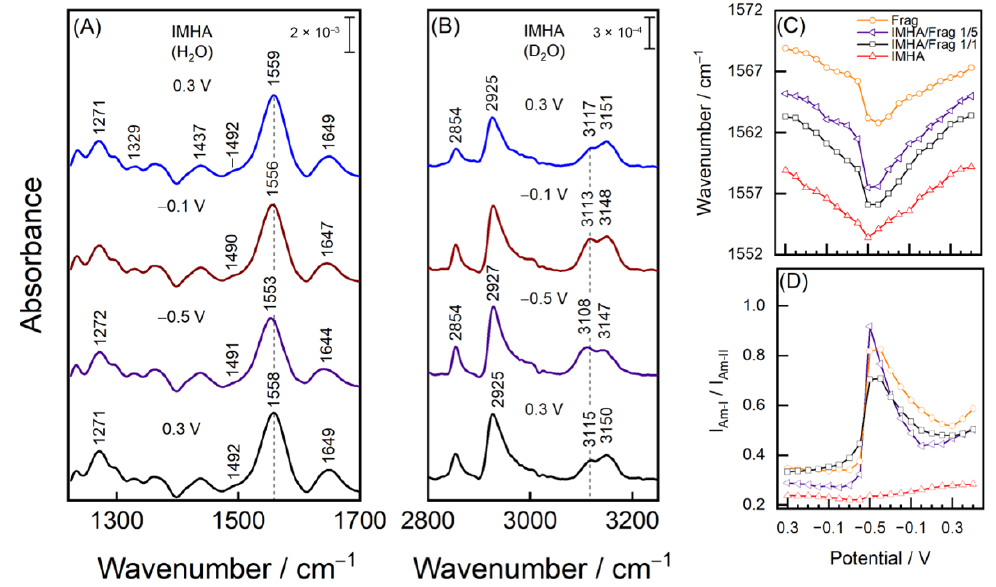
Figure 7. Potential dependent SEIRAS spectra of IMHA monolayer in ( A ) a midrange region in H 2 O and ( B ) C–H stretching region in D 2 O. ( C ) The dependence of Am-II wavenumbers and ( D ) Am-I/Am-II intensity ratio on the electrode polarization.